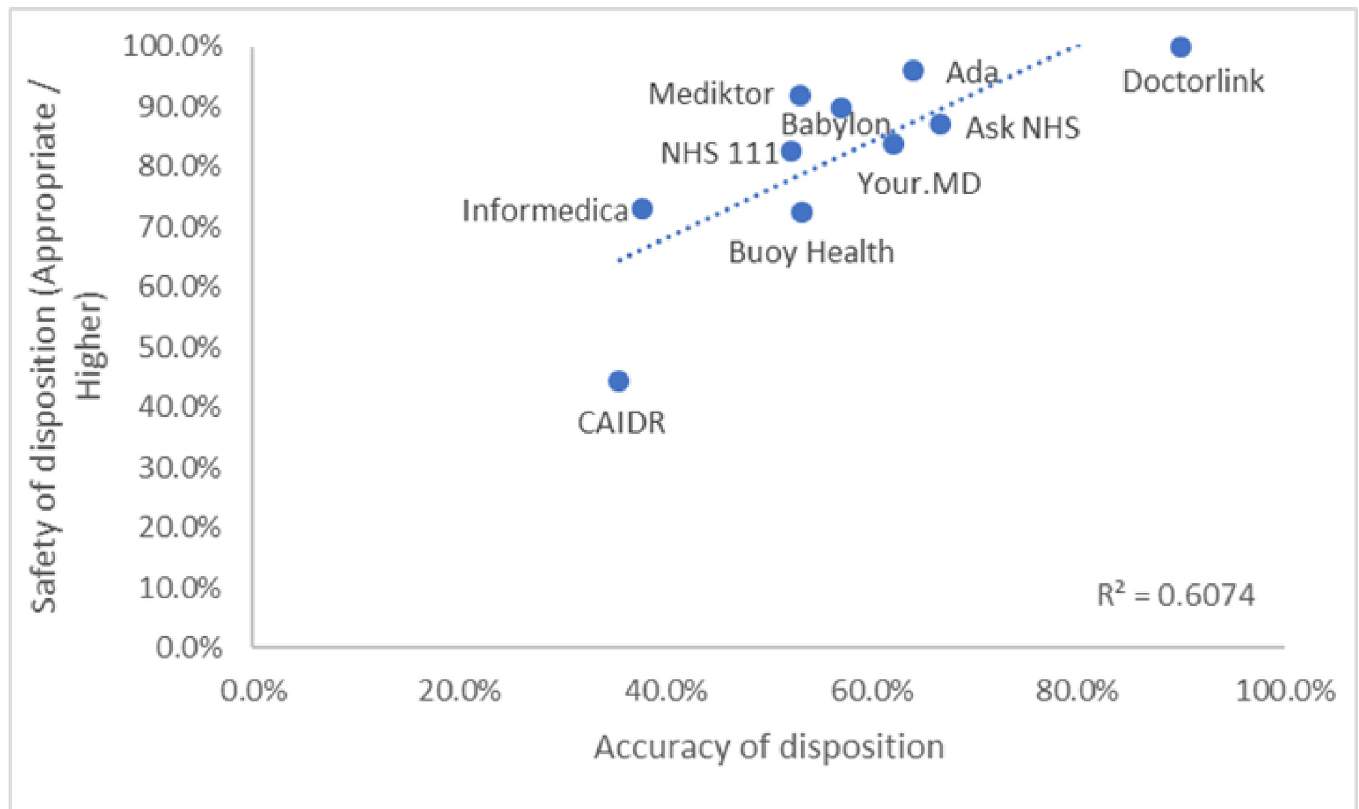
Fig 5. Correlation of triage safety and accuracy of disposition.